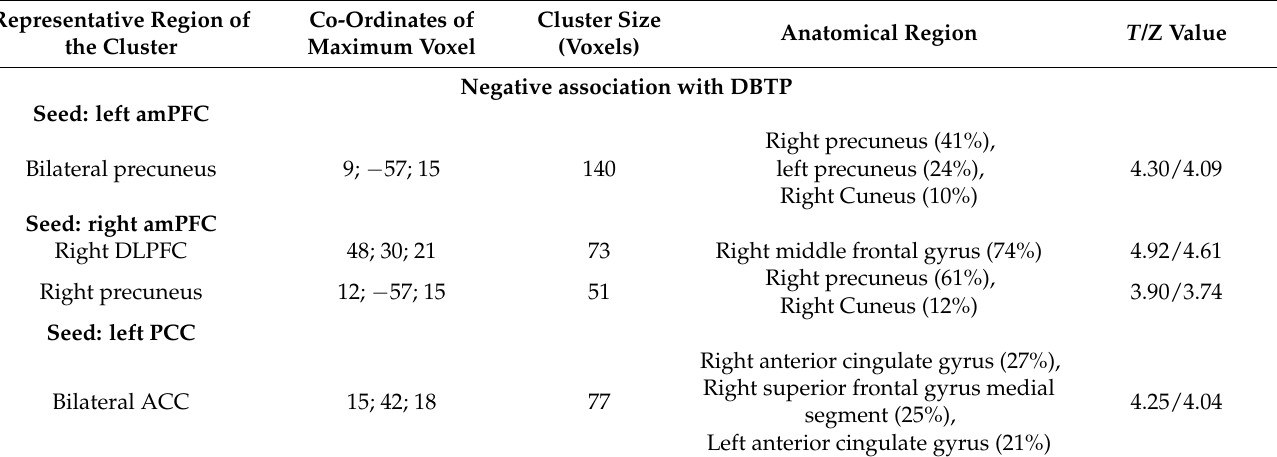
Figure 3. Resting state functional connectivity strength of nodes in DMN (i.e., right amPFC) and FPN (i.e., right DLPFC) showing significant negative correlation with DBTP. DMN = default mode network, FPN = frontoparietal control network, rsFC = resting state functional connectivity (Z- score), amPFC = anterior medial prefrontal cortex, DLPFC = dorsal lateral prefrontal cortex. DBTP = Deviation from Balanced Time Perspective.